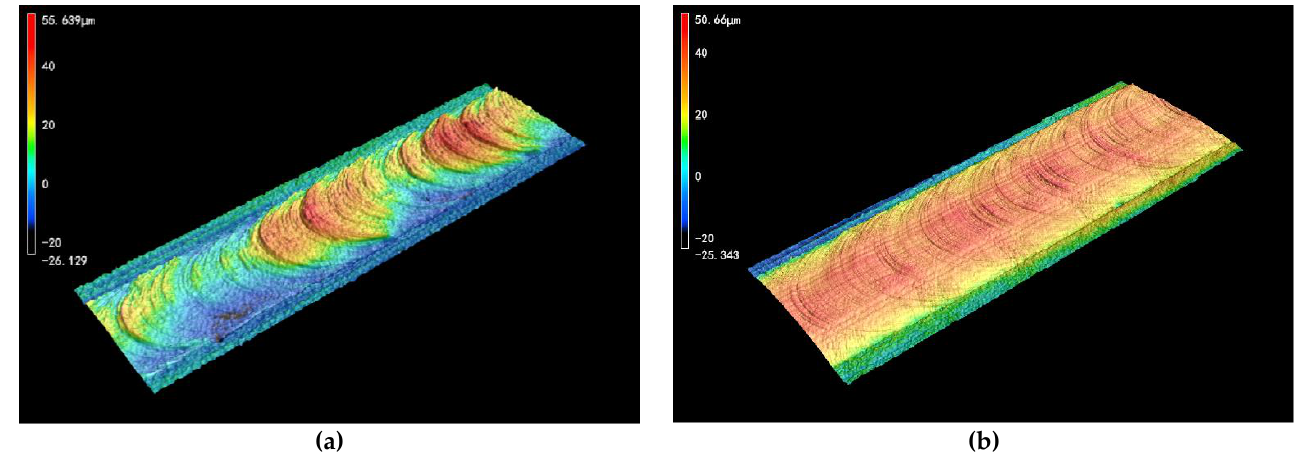
Figure 13. Three-dimensional surface morphology. ( a ) Bz = 0 T; ( b ) Bz = 2.0 T.